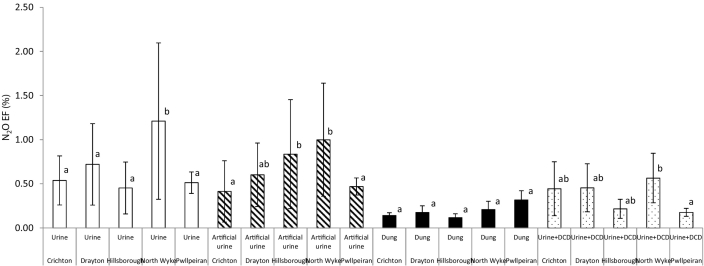
Average N2O EF (across three seasons of application) for each site, for urine and dung treatments.Within each urine/dung treatment, average N2O EFs (from meta-analysis) between sites with different letters are significantly different (N = 3, vertical lines are standard error of the mean).